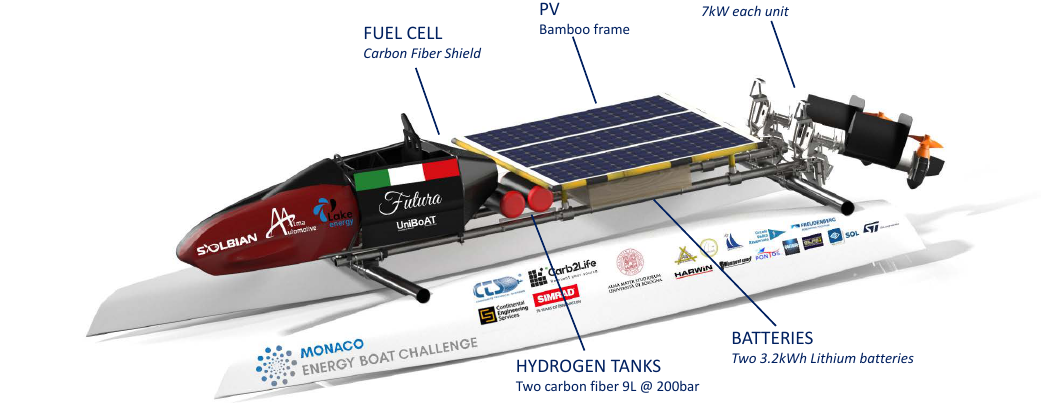
Figure 1. Layout of the racing catamaran Futura developed by